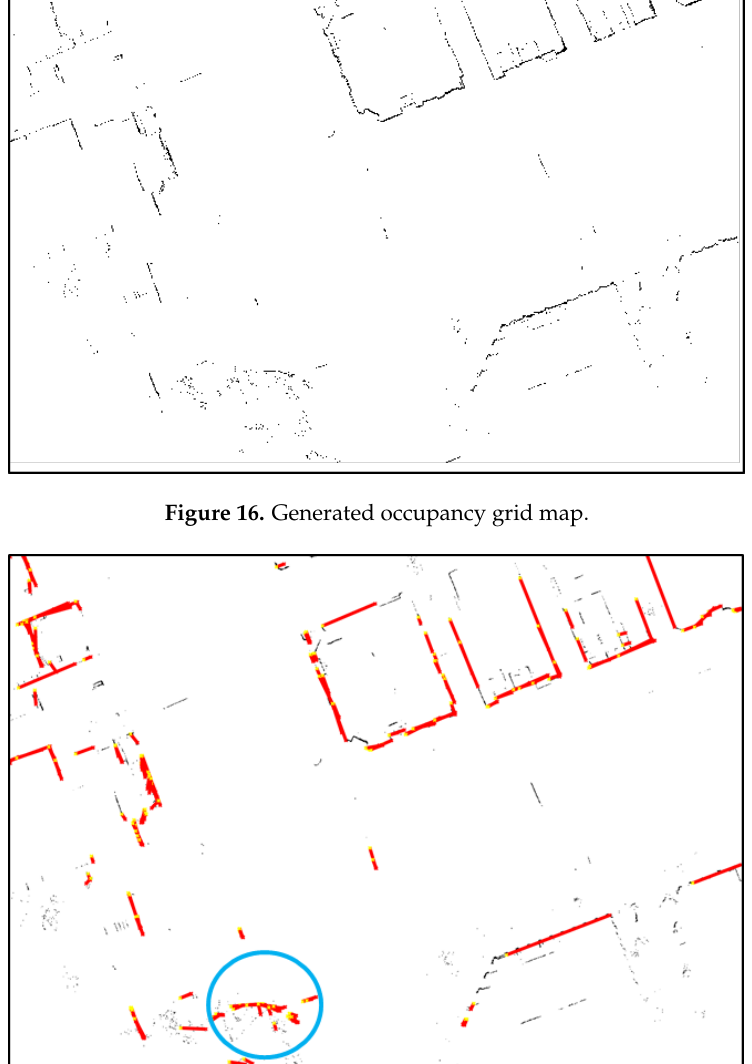
Table 1. Example of